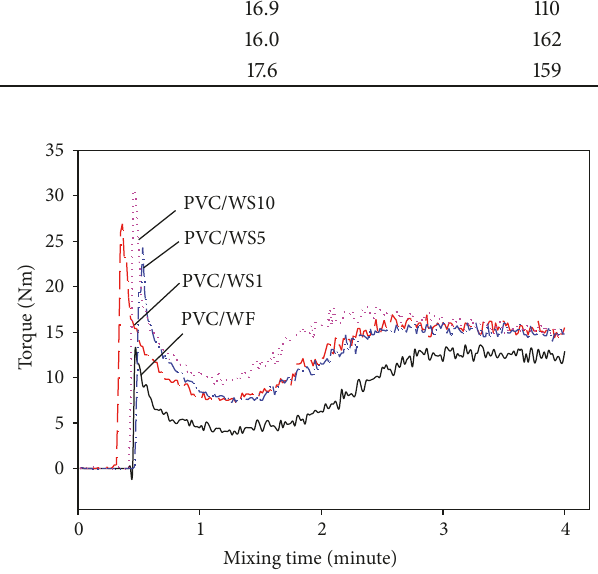
Figure 8: Schematic of torque - mixing time of PVC/WS with various TEOS